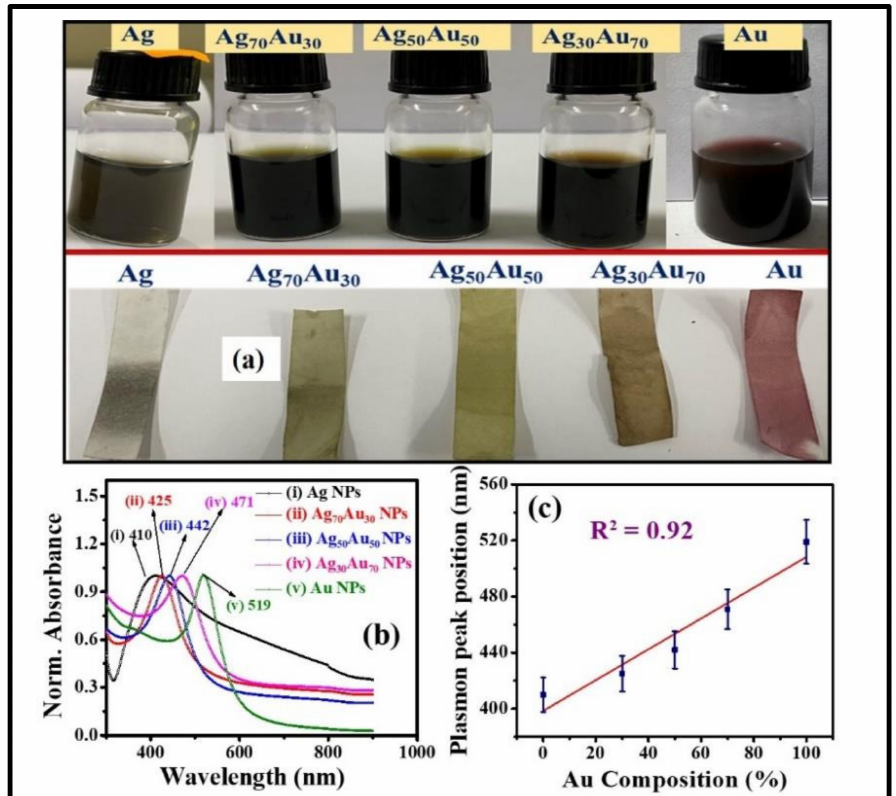
Figure 1. ( a ) Photographic images of as-fabricated Ag-Au alloy NPs including pure Ag and Au NPs (top) and FP soaked with NPs (bottom) ( b ) Normalized UV-Visible absorption spectra of Au-Ag NPs (i) Pure Ag (black) (ii) Ag 70 Au 30 (red) (iii) Ag 50 Au 50 (blue) (iv) Ag 30 Au 70 (pink) and (v) pure Au (green one) ( c ) variation of SPR peak position with increasing Au percentage in Ag-Au alloy